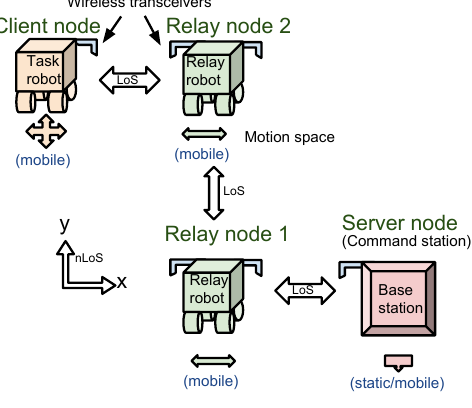
Figure 2. An example architectural view of the SRC networked wireless robot node